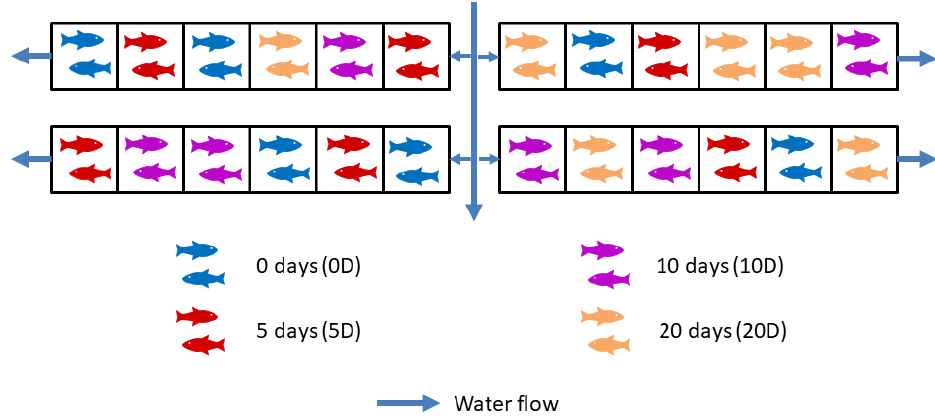
Figure 1. Experimental design. Distribution of trout between the different cages and treatments (pre-slaughter fasting times).